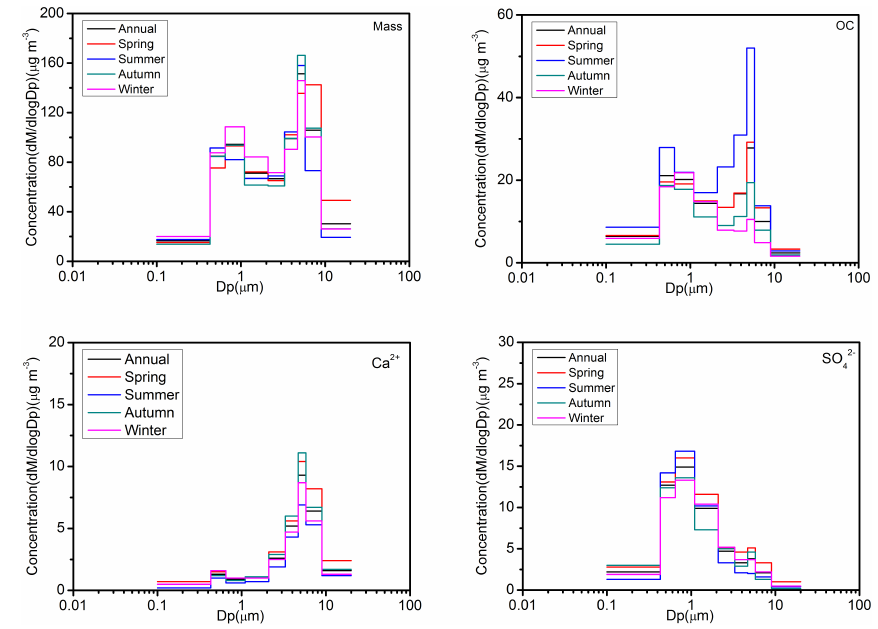
Figure 1. Mass concentration size distributions and those of typical chemical species in different